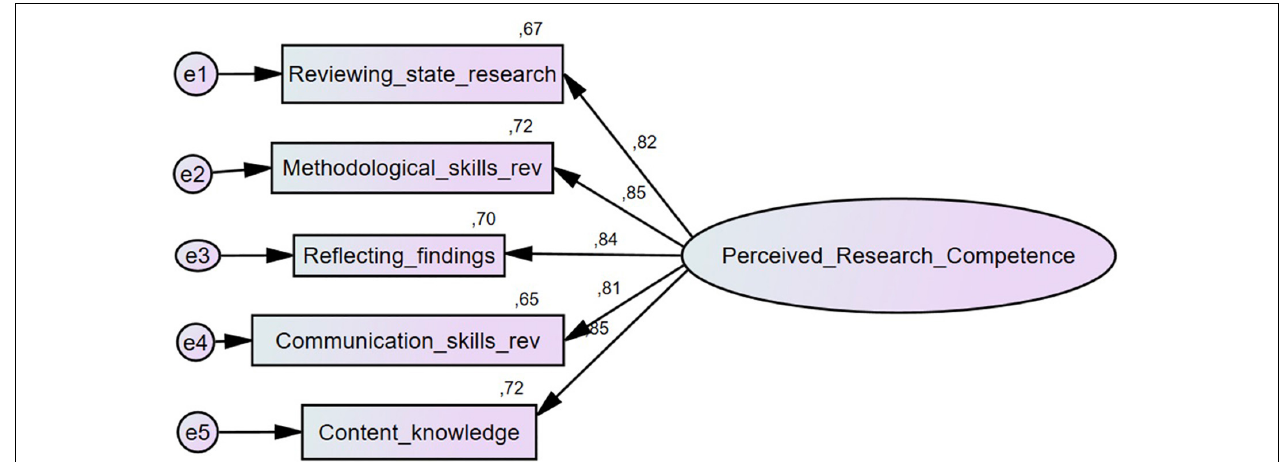
FIGURE 2 | Five-factor model of reduced PR-comp scale. TABLE 6 | Model-fit indices for PR-Comp language-models. Model X 2 (df), p Root mean square